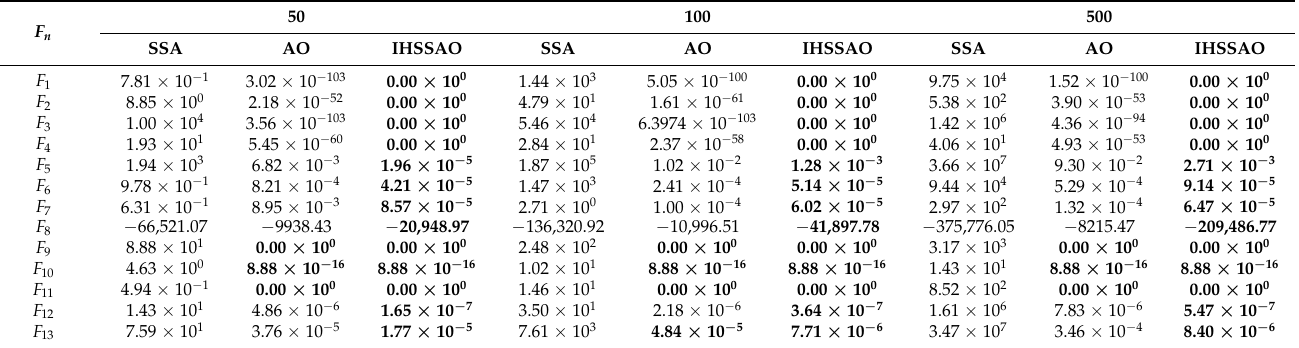
Table 7. Fitness values of SSA, AO, and IHSSAO in 50, 100, and 200 dimensions on 13 test